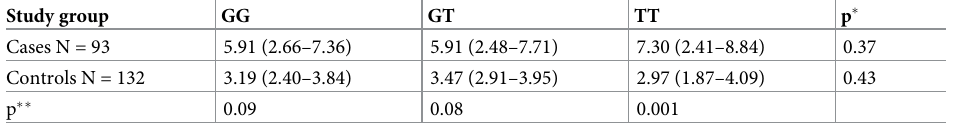
Table 3. Statistical association between serum CRH levels and CRH-R1 rs242924 genotypes in the case and con- trol groups. Study group GG